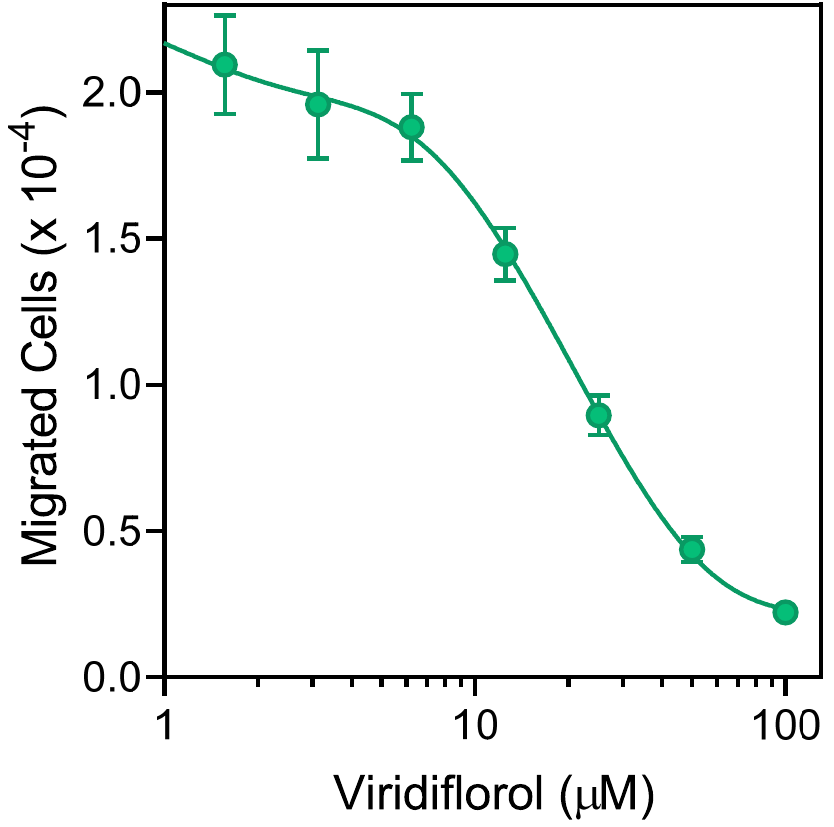
Figure 5. Inhibition of neutrophil chemotaxis by viridiflorol. Neutrophil migration toward 1 nM f MLF was measured, as described under Materials and Methods. The data are from one experiment that is representative of three independent experiments.